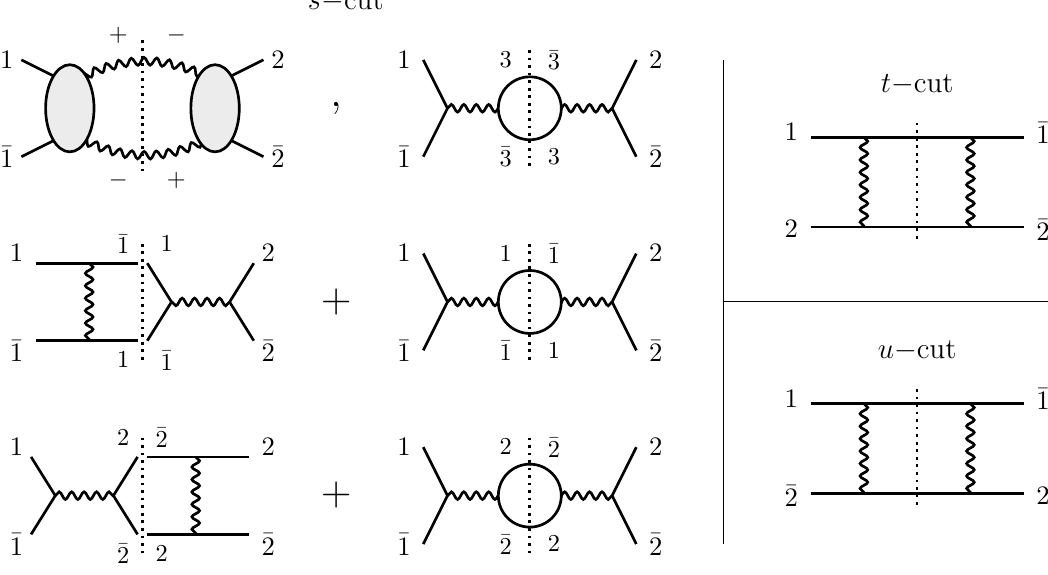
Figure 7 . Cut diagrams entering the computation of the anomalous dimensions at O ( M − 4 eq. (4.40), with solid lines for matter and wavy lines for gravitons. To avoid clutter, we label 1 ≡ Φ , 2 ≡ Φ 0 and 3 ≡ Φ 00 . Diagrams are divided into s -, t - and u -cut. The right column of the s -cut panel corresponds to the universal contribution in eqs. (4.47)–(4.50), proportional to the factor K defined in eq.